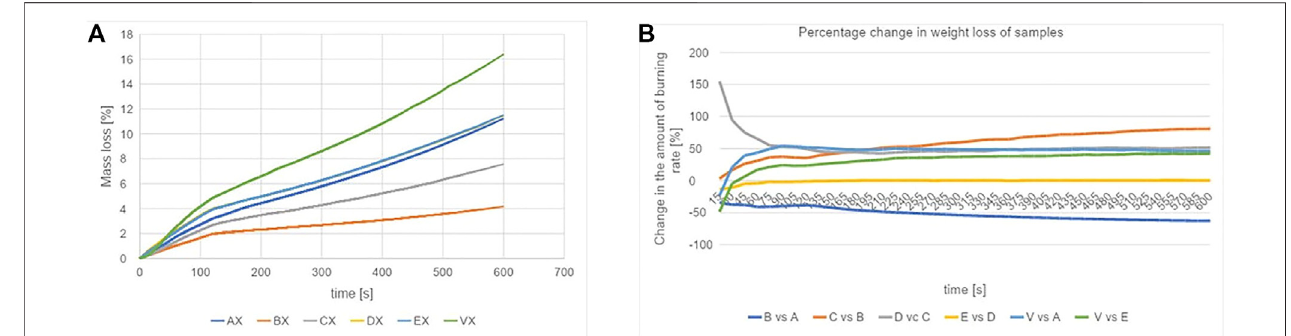
FIGURE 4 | (A) Comparison of mass loss between individual samples; (B) Percentage change in mass loss in samples.